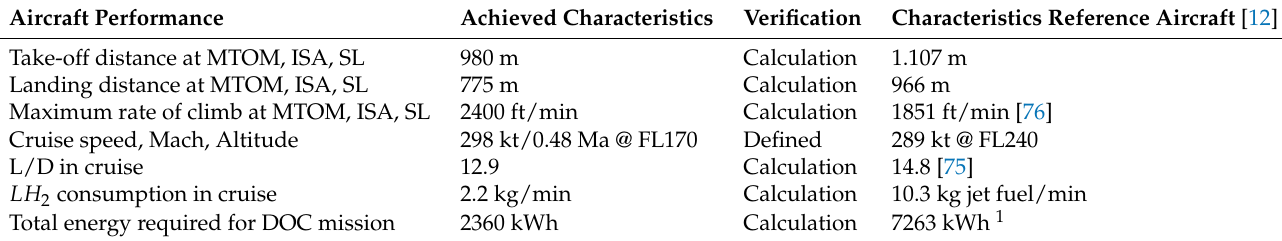
Table 15. Performance